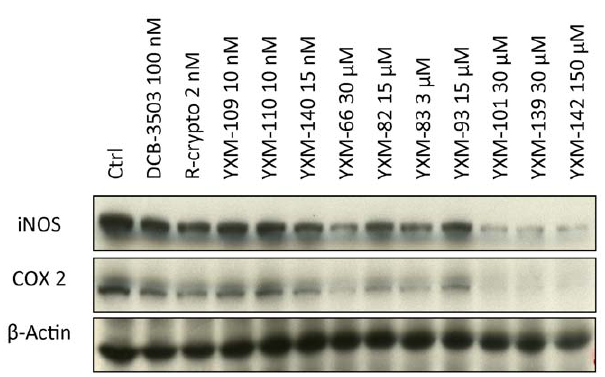
Figure 2. Crytopleurine analogs inhibited Cox 2 and iNOS expression. HepG2 cells were treated with crytopleurine analogs and DCB-3503 with the dosage as indicated in the figure for 4 hours. Protein level of Cox 2 and iNOS was analyzed by Western blot. Results were representative of three independent